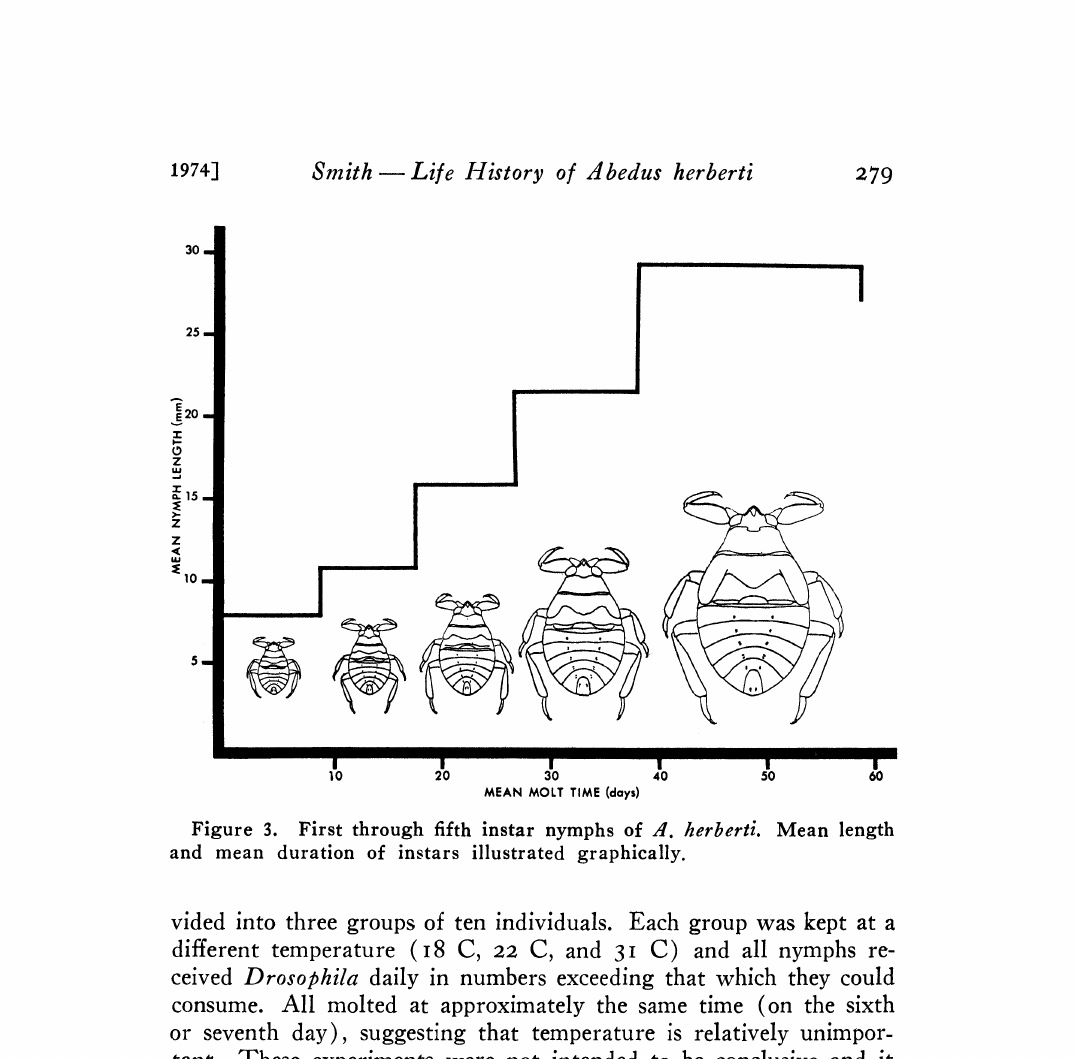
Figure 3. First through fifth instar nymphs of At. herberti. Mean length and mean duration of instars illustrated graphically. vided into three groups of ten individuals. Each group was kept at a different temperature (8 C, 22 C, and 3t C) and all nymphs re- ceived Drosophila daily in numbers exceeding that which they could consume. All molted at approximately the same time (on the sixth or seventh day), suggesting that temperature is relatively unimpor- tant. These experiment’s were not intended to be conclusive and it is probable that a food-temperature interaction could be detected with more sophisticated